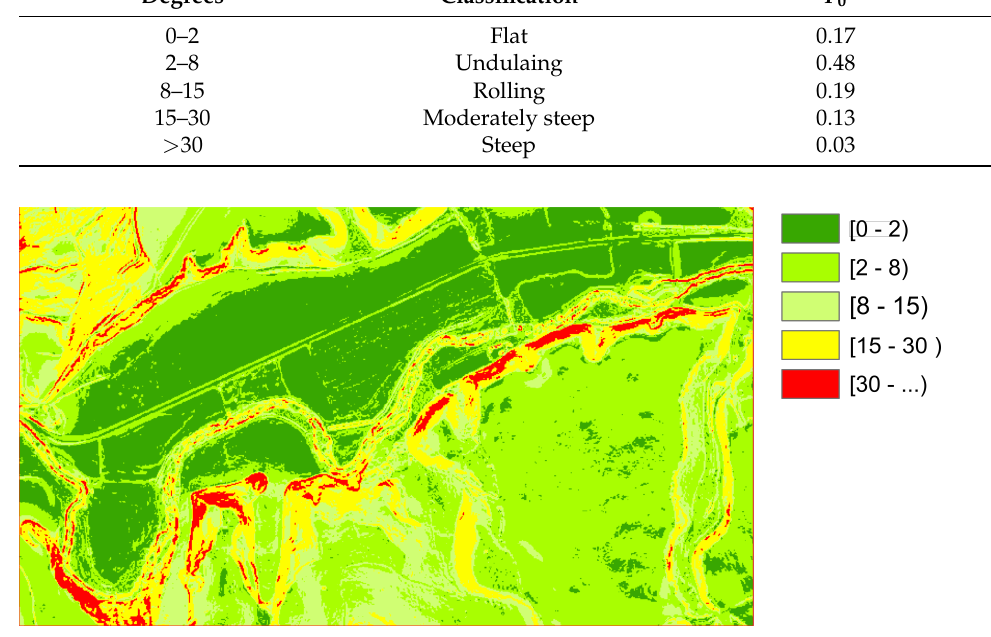
Figure 6. Classification of slopes: Case #2 (example in the sub-area shown in Figure